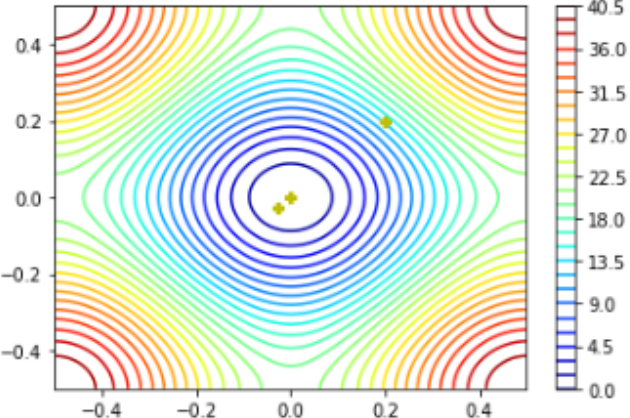
Figure 11. Global minima of the Rastrigin function using BFGS